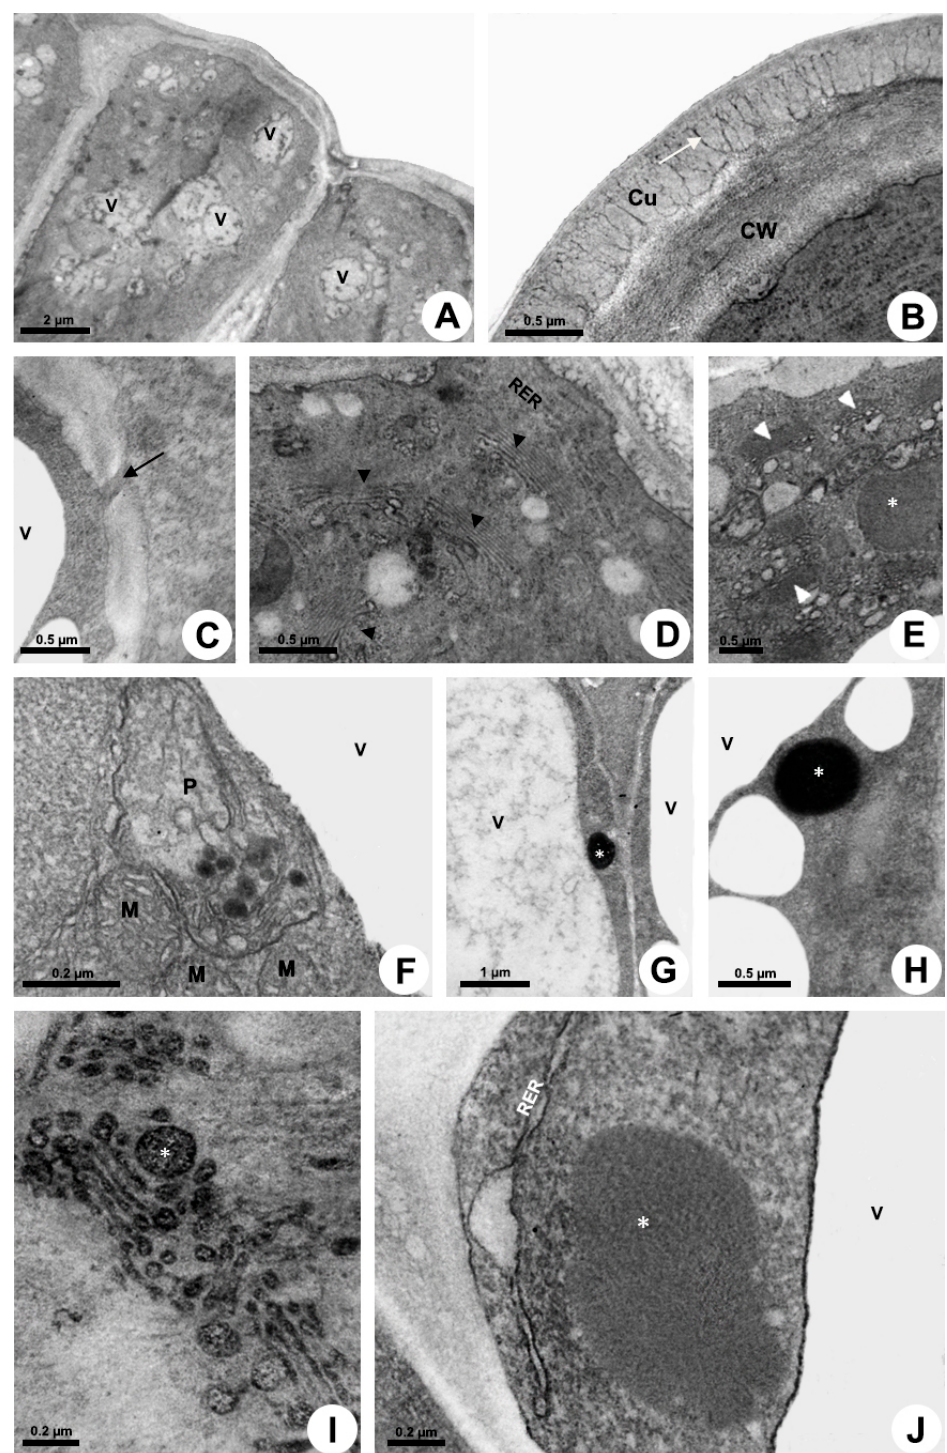
Figure 3. Ultrastructure of the colleter secretory cells of Mandevilla splendens ( A – H , J ) and Peplonia axillaris ( I ). Transmission electron microscopy. ( A ) General view. ( B ) Cuticle (Cu) with pectin projections (arrow) from the cell wall (CW). ( C ) Plasmodesma (arrow). ( D , E , G – J ) Abundant dictyosomes (arrowhead) and RER in parietal position. Note vesicles filled with mucilage (asterisk). ( F ) Plastid (P) with plastoglobules surrounded by many mitochondria (M). ( G , H ) Detection of polysaccharides within vesicles with PATAg test (asterisk). ( I ) Detection of mucilage in the dictyosome vesicles using ruthenium red test (asterisk). ( J ) Beginning of a vesicle formation from RER close to plasma membrane.